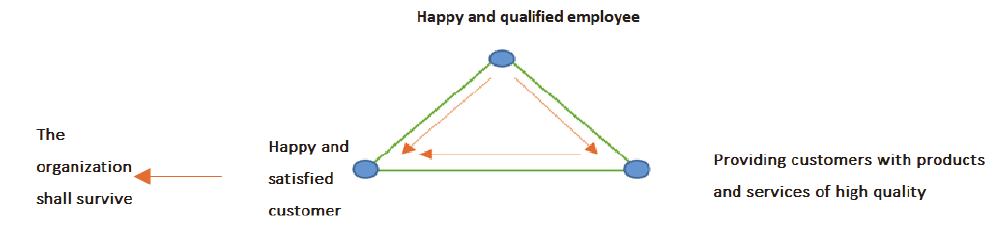
Fig. 2. The triangle of quality (source: Al-E’qaily, 2015